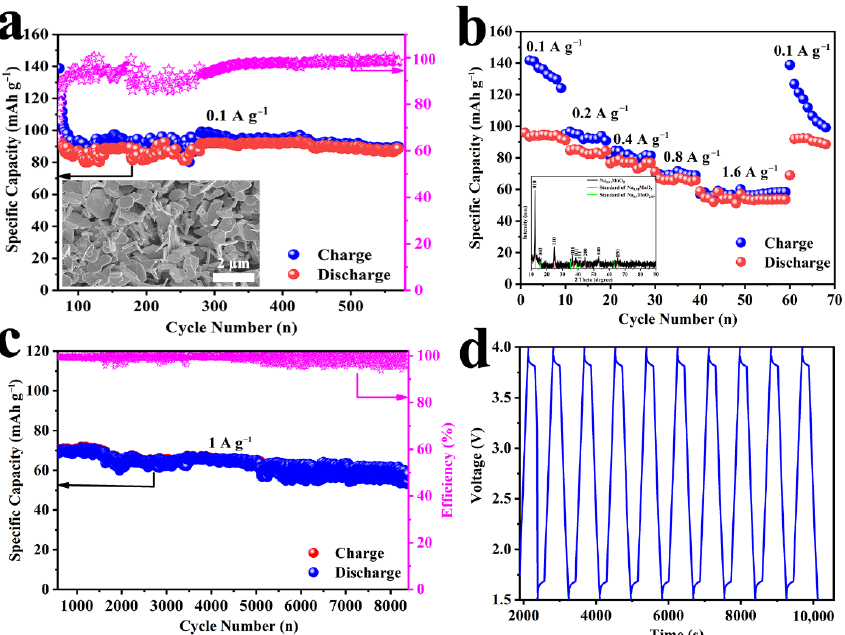
Figure 4. ( a ) Cycle performance of Na 0.91 MnO 2 hexagonal tablets (NMO HTs) vs. sodium-tin alloy in situ electrochemically derived directly collected for 570 cycles at 0.1 A g − 1 ; ( b ) Capacity evolution of NMO HTs vs. sodium-tin alloy in situ electrochemically derived by evolving current densities ranging from 0.1, 0.2, 0.4, 0.8, 1.6 A g − 1 and transfer to 0.1 A g − 1 (inset, XRD of NMO HTs); ( c ) Cycle performance for 8400 cycles at 1 A g − 1 directly collected after the various current densities for NMO HTs vs. sodium-tin alloy in situ electrochemically derived were tested; ( d ) The profiles of voltage vs. specific capacity for NMO HTs vs. sodium-tin alloy at 1.5–4.0 V between 4290th and 4300th cycles.